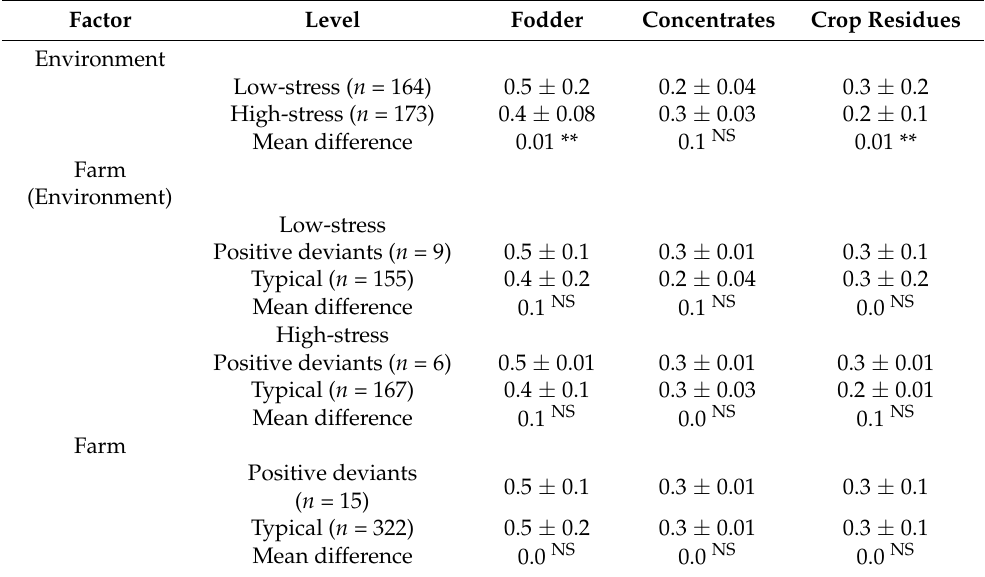
Table 5. Mean ( ± SD) proportions of fodder, concentrates and crop residues in the diets fed to dairy cattle in positive deviants and typical farms under contrasting environments.